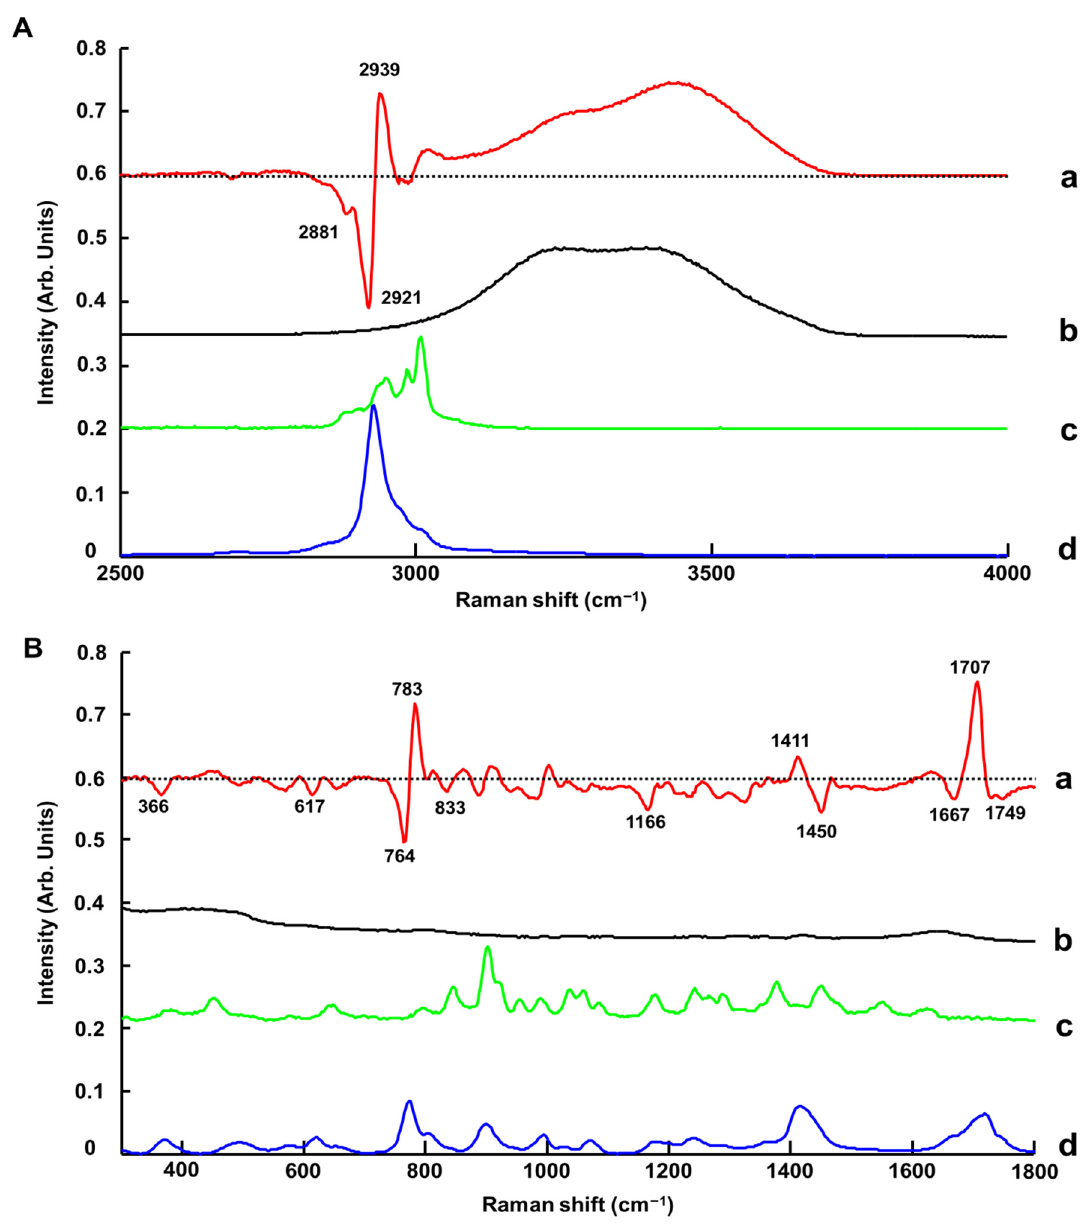
Figure 9. First regression coefficient from PLSR (a), water spectrum (b), L-Proline (c) and Levulinic Acid (d) in the 2500–4000 cm − 1 spectral range ( A ) and the 300–1800 cm − 1 spectral range ( B ). Dotted line indicates the zero baseline. Spectra are offset for clarity.